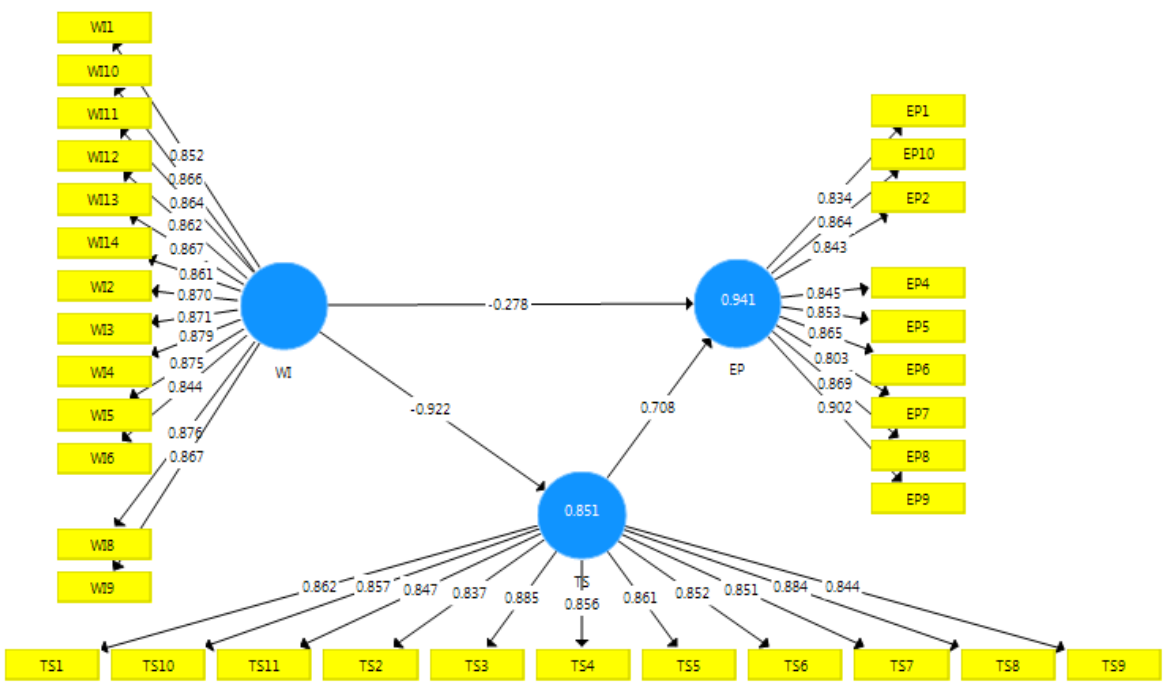
Figure 2. The research framework tested using SmartPLS. Table 5. Relationship of the variables.